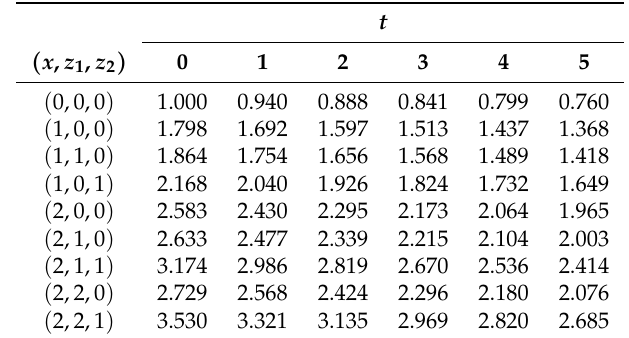
Table 4. BMP’s for claims when there are x claims, z 1 with a claim size between ψ 1 and ψ 2 , z 2 claims with a size larger than ψ 2 and x − z 1 − z 2 claims with a claim size smaller than ψ 1 with p x = 0.25, p y = 0.50 and p z =